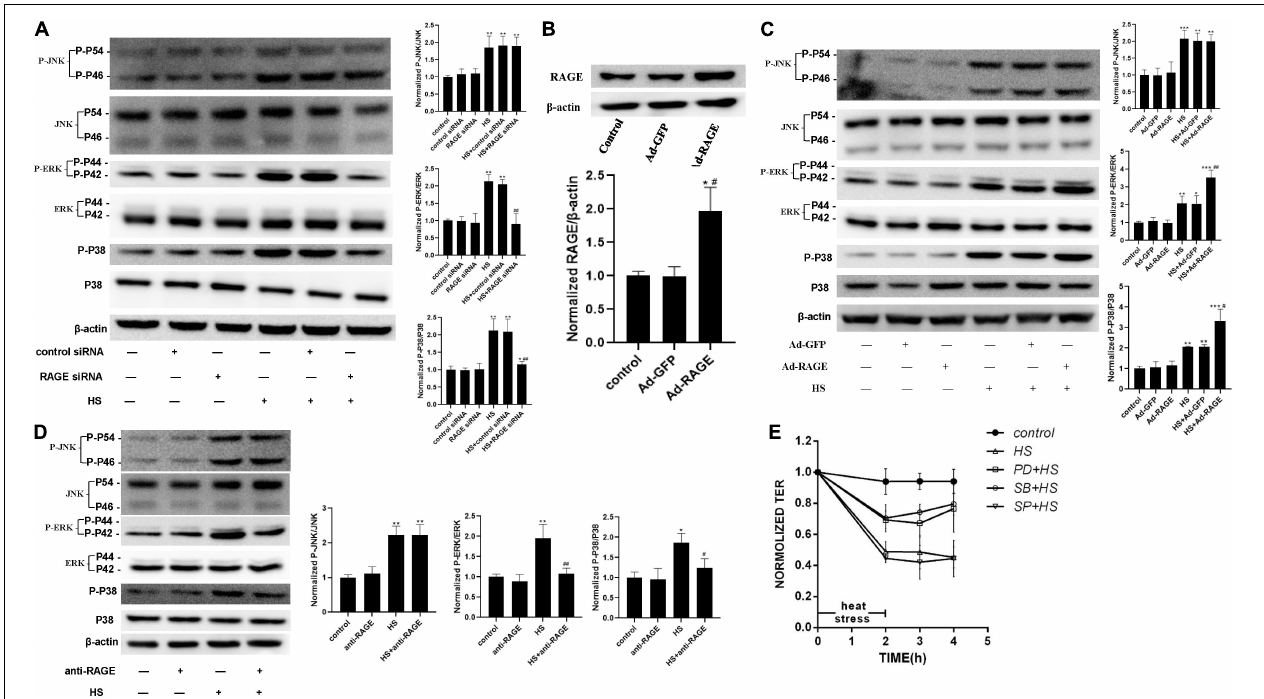
FIGURE 5 | ERK and P38 MAPK involved in the signal pathway by which RAGE involved in heat-induced endothelia barrier dysfunction. (A) HUVECs were treated with either control or RAGE siRNA. Cells were then subjected to heat stress at 42 ◦ C for 2 h. Samples were harvested 2 h after heat exposure. The protein expression and phosphorylation of JNK, ERK, and P38 were evaluated by western blot analysis. β -actin was used as a loading control. the phospho/total MAPK is normalized to 1 in the untreated control. (B) Evaluation of transfection efficiency of adenovirus expressing RAGE. Cells were infected with Ad-RAGE or Ad-GFP for 48 h, and total protein was extracted and subjected to western blot to evaluate the expression of RAGE. (C) Cells infected with Ad-RAGE or Ad-GFP were subjected to heat stress at 42 ◦ C for 2 h. Samples were harvested 2 h after heat exposure and analyzed by western blot. (D) HUVEC monolayers were treated with heat at 42 ◦ C for 2 h after an absence (control) or presence of RAGE antibody for 1 h. Samples were harvested 2 h after heat exposure. The protein expression and phosphorylation of JNK, ERK, and P38 were evaluated by western blot analysis. (E) HUVEC monolayers were treated with heat at 42 ◦ C for 2 h after an absence (control) or presence of JNK, ERK, or P38 MAPK inhibitor for 1 h. Samples were harvested 2 h after heat exposure. TEER was recorded before (used as a baseline) and after heat Stress. Values are presented as a percentage relative to that before heat stress ( n = 3; * P < 0.05, ** P < 0.01, *** P < 0.001 vs control group, # P < 0.05, ## P < 0.01 vs HS